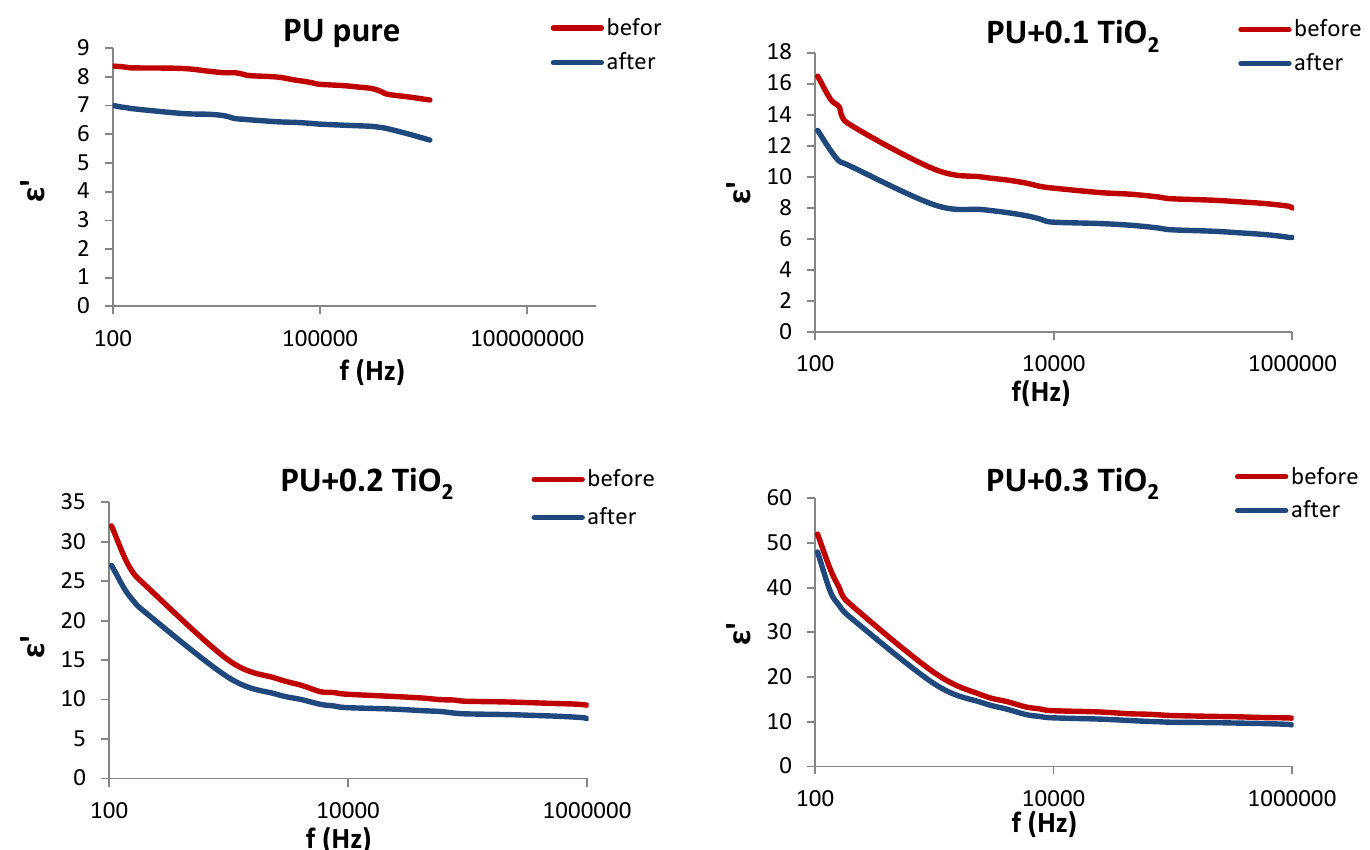
Fig. 4: Variation of dielectric constant as a function of frequency before and after UV irradiation for PU and (PU-TiO ) 2